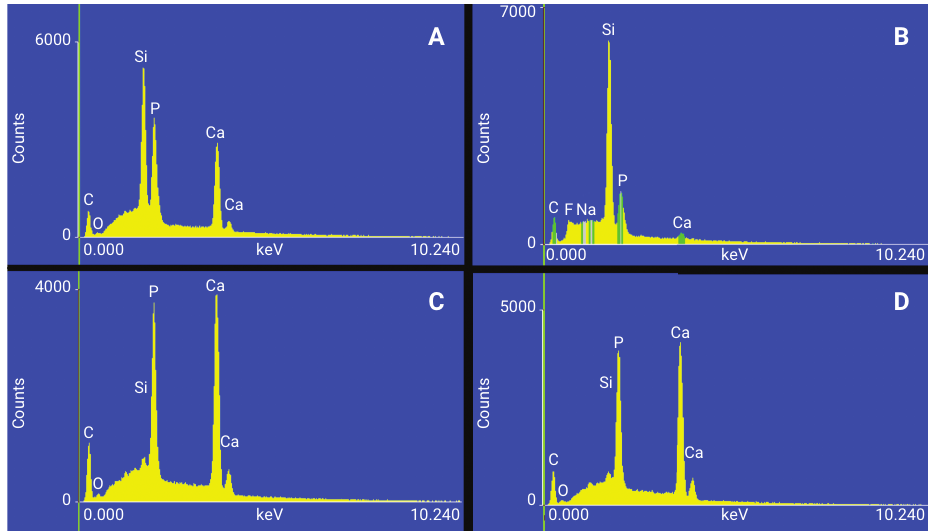
Figure 1. Identified elements by EDS analyses (A) Clearfil SE Bond, (B) Biofluorid 12 + Clearfil SE Bond, (C) MS Coat One + Clearfil SE Bond, and (D) Gluma Confort Bond +